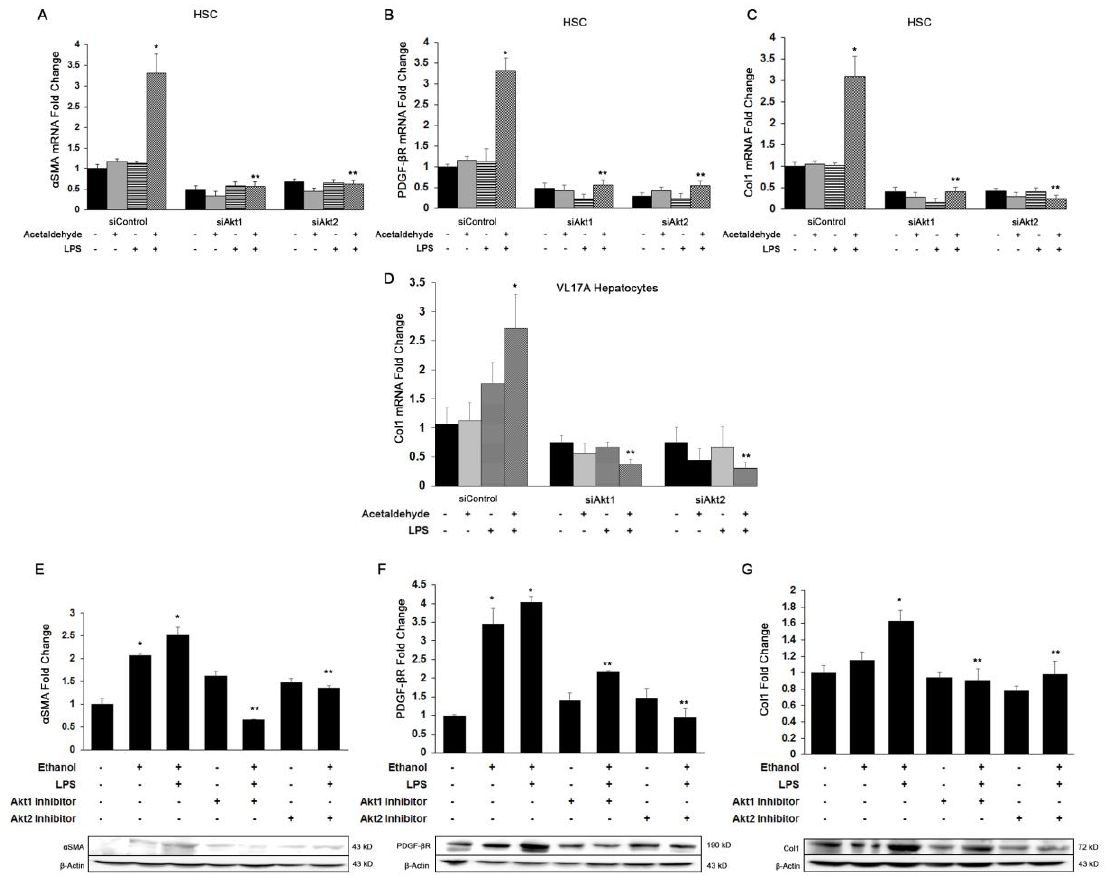
Figure 3. Role of Akt1 and Akt2 in ethanol and LPS-induced fibrogenesis. Total RNA was extracted from human hepatic stellate cells (HSC) or VL17A hepatocytes transfected with siAkt1 or siAkt2 and treated with acetaldehyde / ethanol, LPS, or both for quantitative PCR analysis of ( A ) α S ma, ( B ) Pdgf β receptor, ( C ) Col1 α 1 , and ( D ) Col1 α 1 from VL17A cells. Total protein was extracted from whole liver tissue from mice of various groups ( n = 6) to determine the protein expression of ( E ) α SMA, ( F ) PDGF β Receptor, ( G ) Col1 by Western blot analysis. All values are means of triplicate experiments ± SE after correcting for the expression of glyceraldehyde-3-phosphate dehydrogenase ( Gapdh ) (mRNA) or β -actin (protein). * p < 0.05 as compared to control; ** p < 0.05 as compared to acetaldehyde + LPS or EBL.